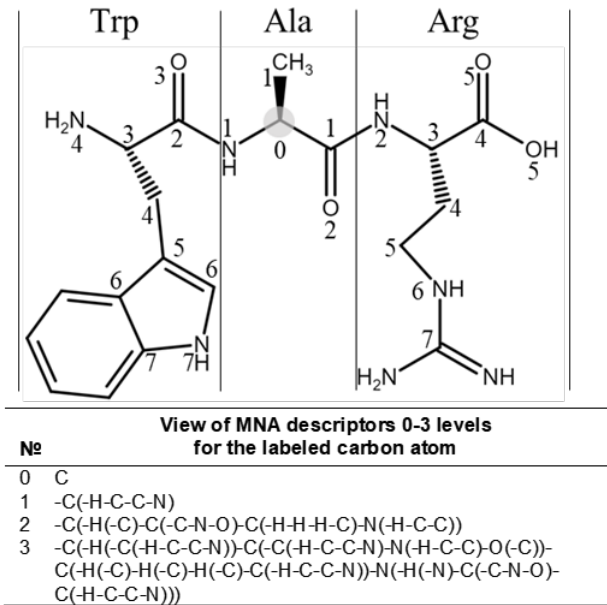
Figure 3. The example of 0-3 levels of MNA (Multilevel Neighborhoods of Atoms) descriptors is shown for the carbon atom of alanine in the polypeptide chain fragment. The numbers in the structural formula show the most distant atoms included in the descriptor of the related level of MNA descriptors. The appropriate descriptors of the chosen level are generated for all atoms in the structural formula. Such description helps to depict the linear structure of peptides completely and explicitly.